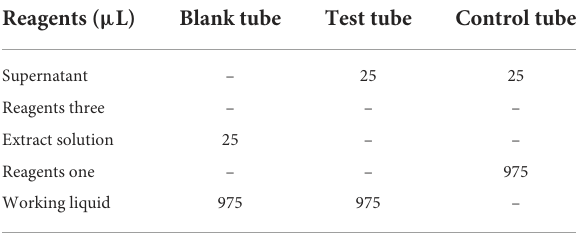
TABLE 1 Proportion of reagents in EP